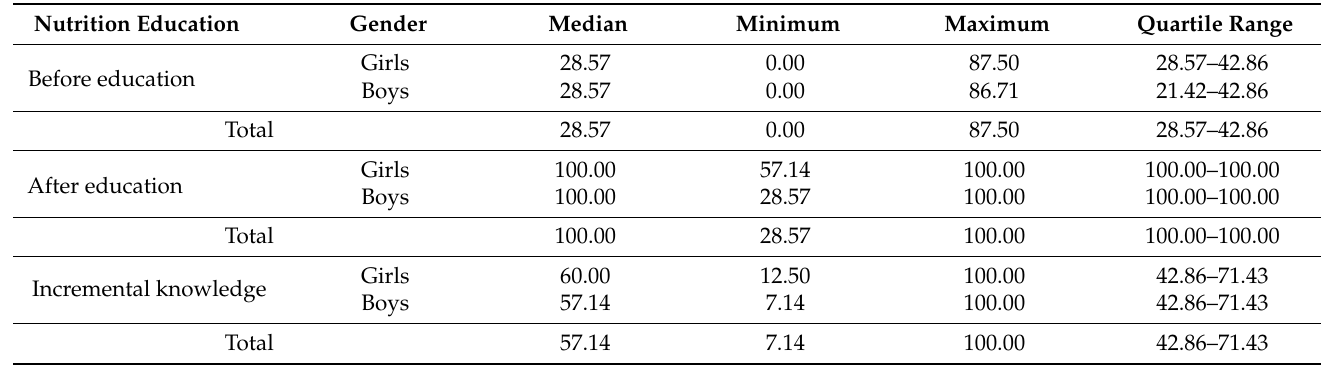
Table 5. Percentage of correct answers to knowledge questions.